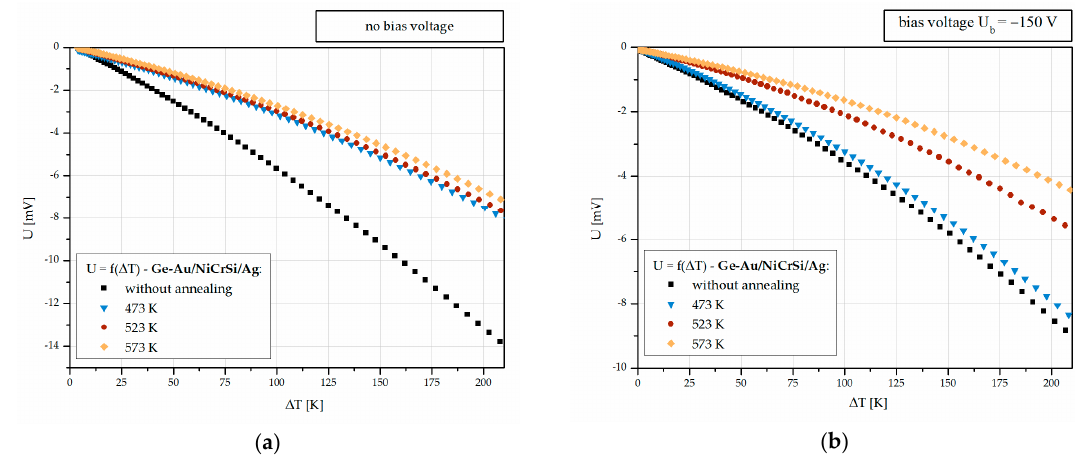
Figure 6. Thermoelectric voltage U as a function of temperature difference ∆ T between thermocouples before and after annealing: ( a ) Ge–Au/NiCrSi/Ag test structures deposited in the sputtering process without external bias voltage; ( b ) Ge–Au/NiCrSi/Ag test structures deposited in the sputtering process with external bias voltage.